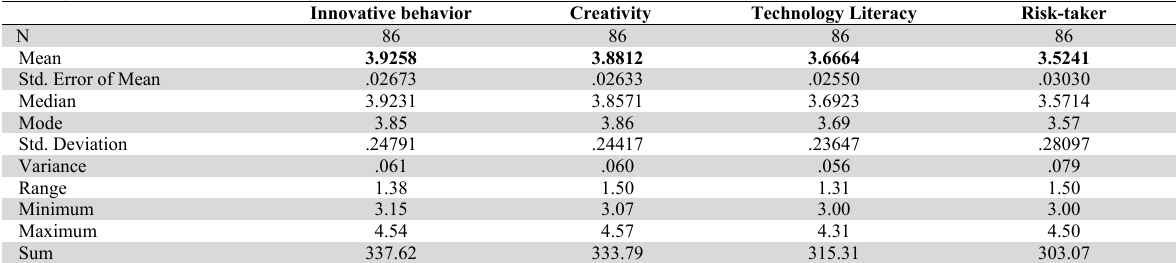
Description of Data of Y, X 1 , X 2, and X 3 Variable Innovative